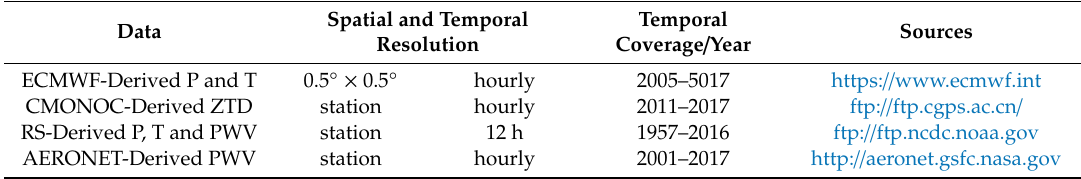
Table 1. Characteristics of datasets selected in the